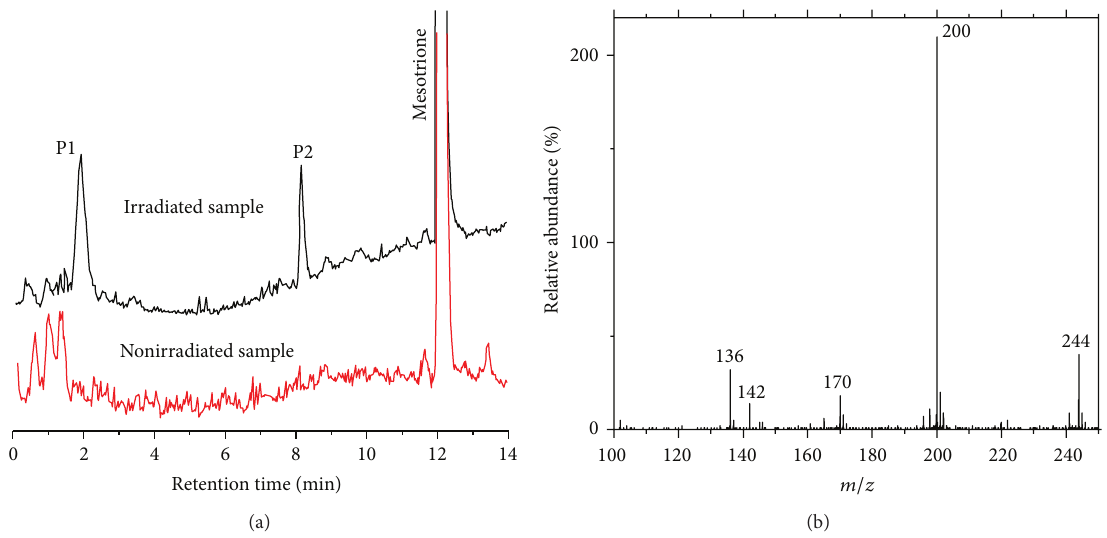
Figure 4: (a) HPLC chromatogram of a solution obtained by extraction with methanol of an irradiated mixture mesotrione/Kaolinite at = 250 nm using a gradient program (see Section 2). (b) Mass spectrum of product P1. [Mesotrione] = 5.2 𝜇 molg −1 . Irradiation was 𝜆 max performed in a Sunlight simulator.